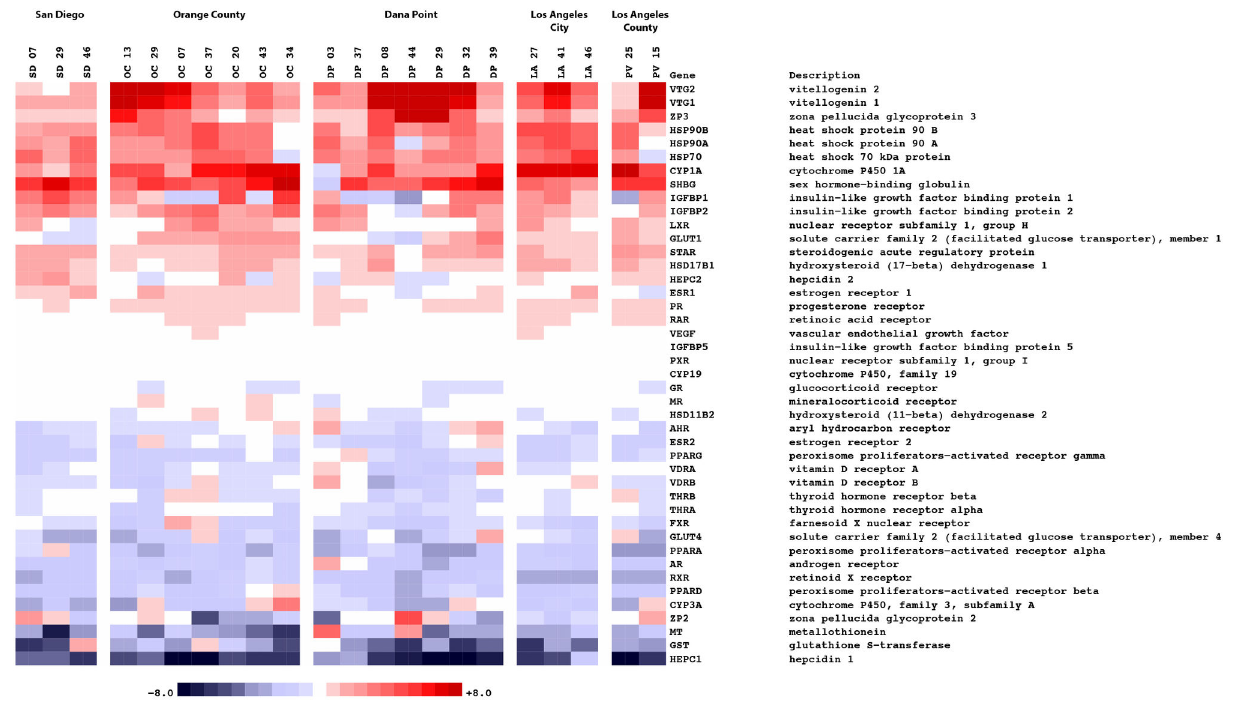
Figure 3. Multi-species microarray gene expression profiling of turbots for exposure to endocrine disruptors. The mRNA level fold changes observed between exposed and control fish are depicted as a diagnostic heat map representative of all the genes present on the multi-species array. The log ratio for each gene is defined as the mean of all representations of that gene on the 2 microarray; these include probes from different regions of the gene, as well as from different species of fish (individual log each unique probe are calculated as the median of 46 replicates present on the array). The range of colors is between -8-fold and +8-fold and preserves qualitative relationships among individual values. All fold changes outside of this range have been truncated to ±